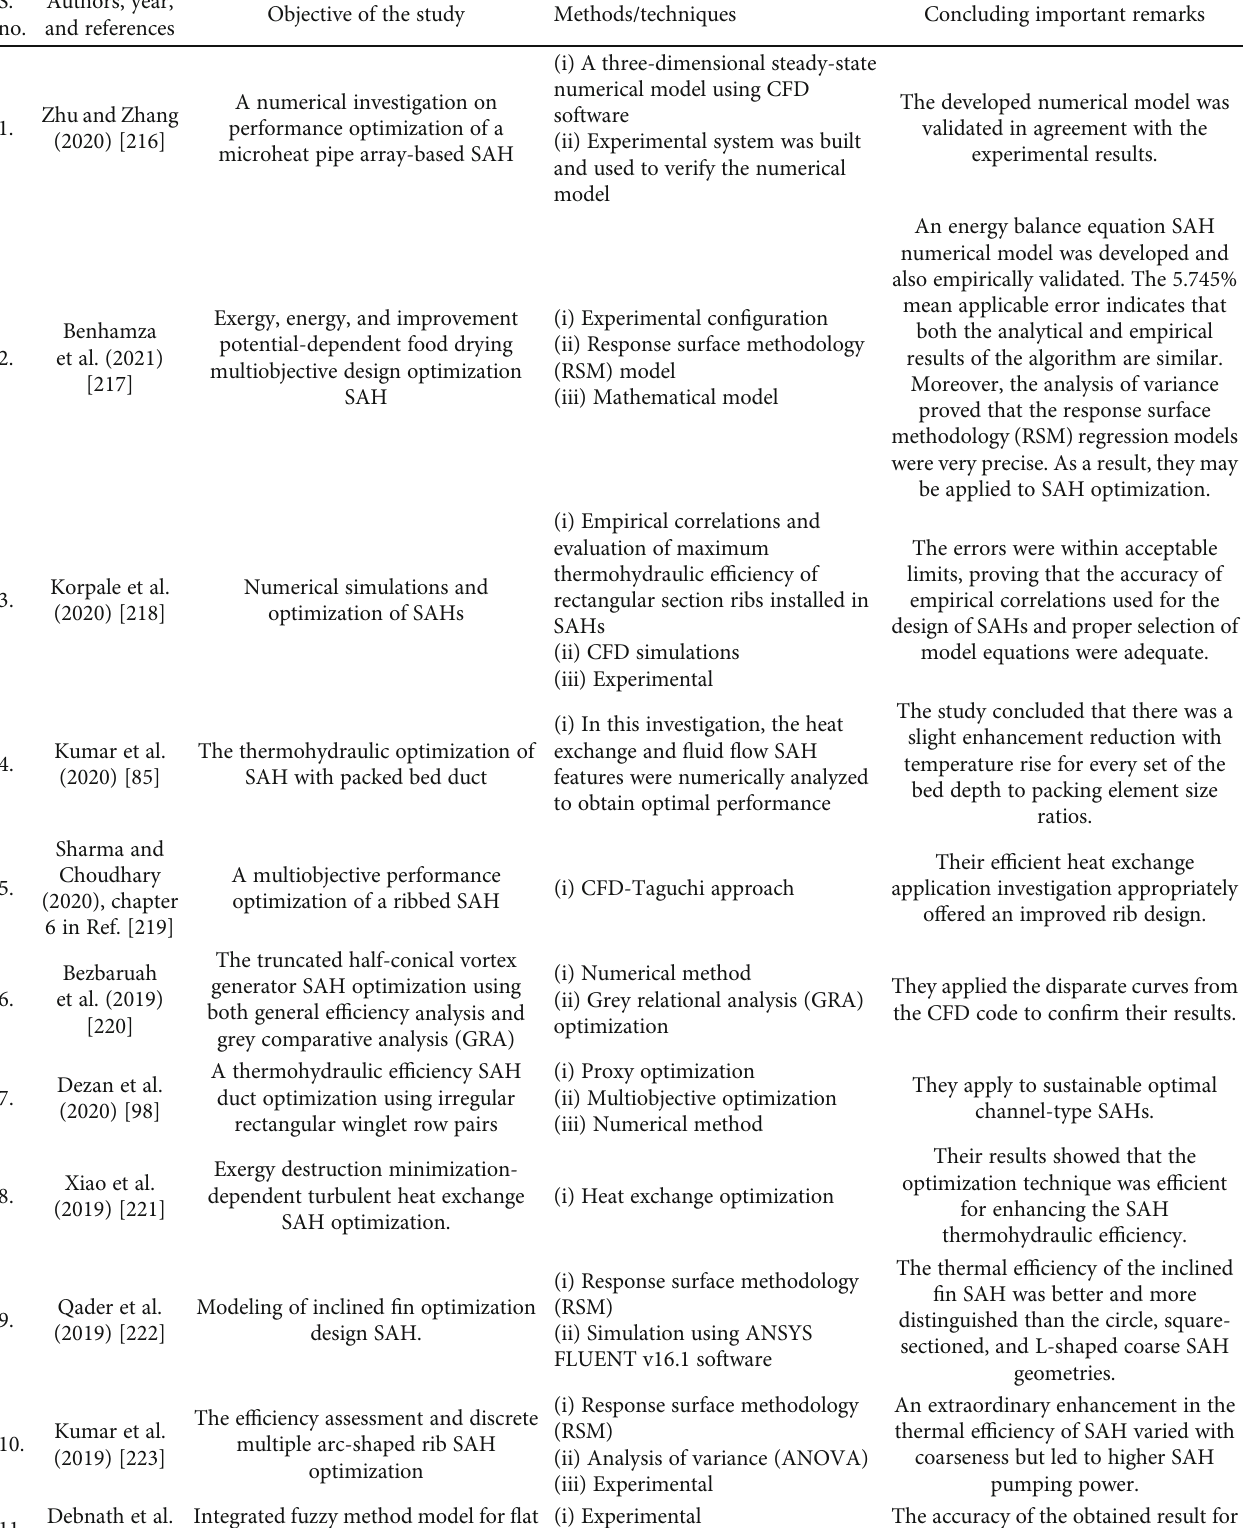
Table 6: The very recent papers on the existing methods and techniques used by other researchers in the optimization of solar air heaters (2019-2021).